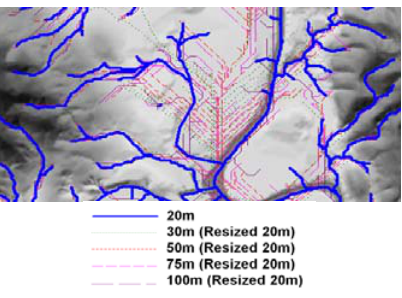
Figure 12. Waterways derived from 20m DEM resized to 30, 50 and 75 and 100 m DEMs